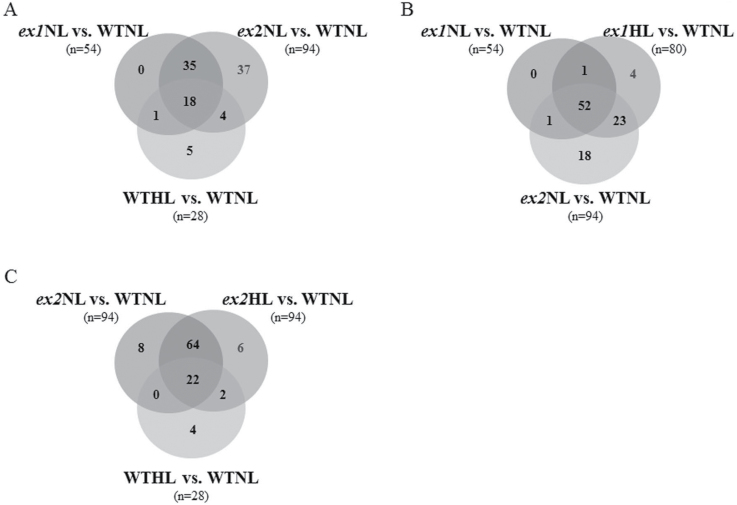
Venn diagram analyses showing common and differential distribution of protein spots detected by DIGE in stromal preparations of Arabidopsis plants in response to light and genotype, using as reference WT in normal growth light conditions (WTNL). (A) Overlay of the responsive proteins in WT upon light treatment (WTHL), and the two executer mutants in normal growth light conditions (ex1NL and ex2NL, respectively); (B) Overlay of the responsive proteins in ex1 plants upon light treatment (ex2HL) and the two executer mutants in normal growth light conditions (ex1NL and ex2NL, respectively); (C) Overlay of the responsive proteins in WT upon light treatment (WTHL) and the ex2 mutants both in normal light (ex2NL) and high light (ex2HL) conditions.